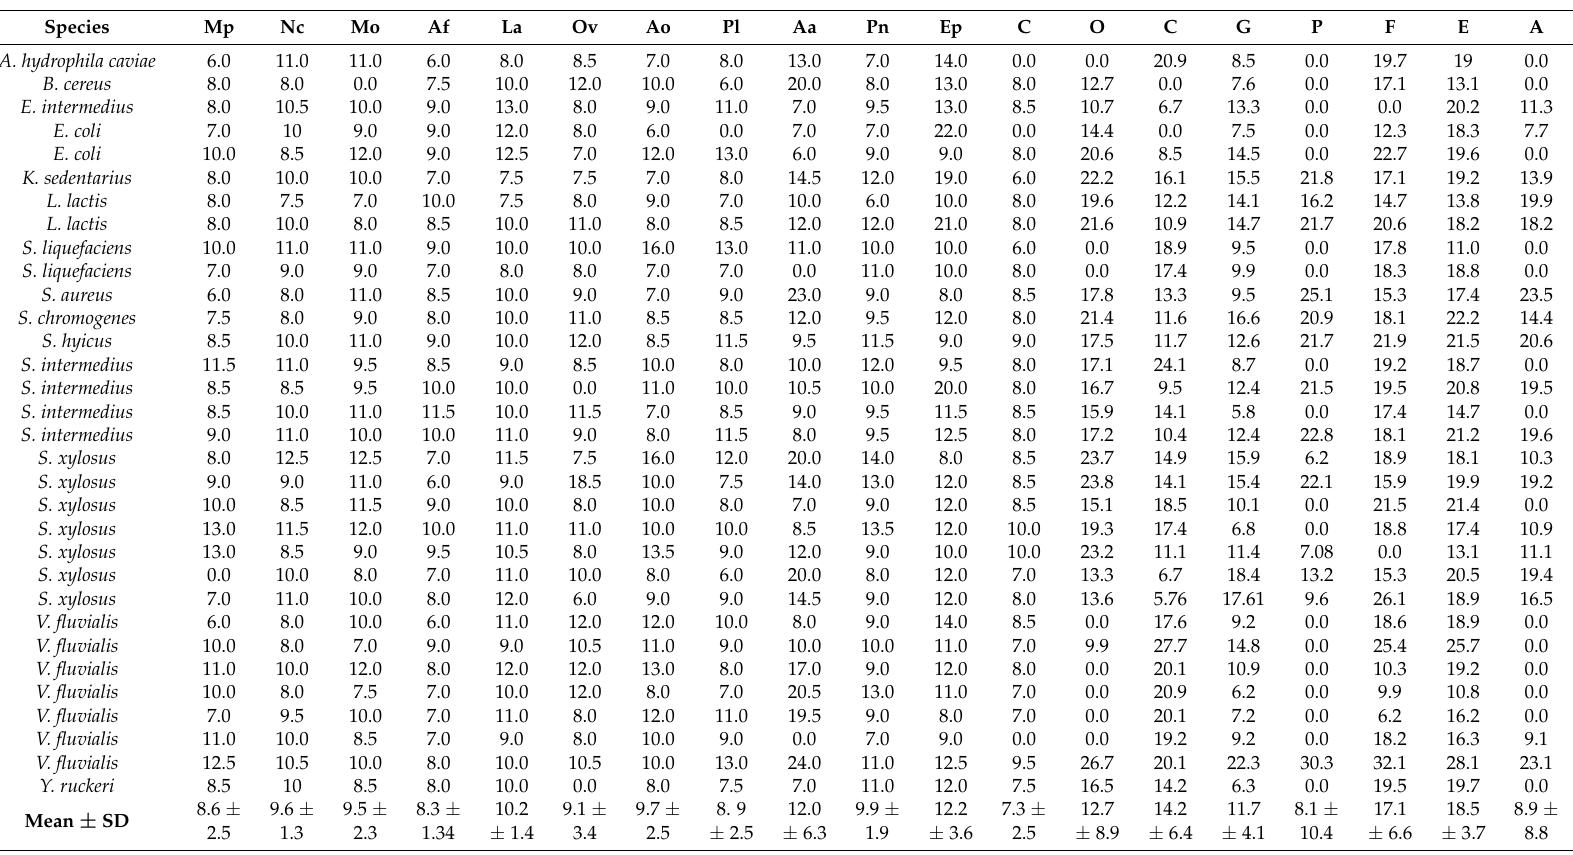
Table 3. Antimicrobial activity of plant extracts, negative control and antibiotics used, (mm, zone of